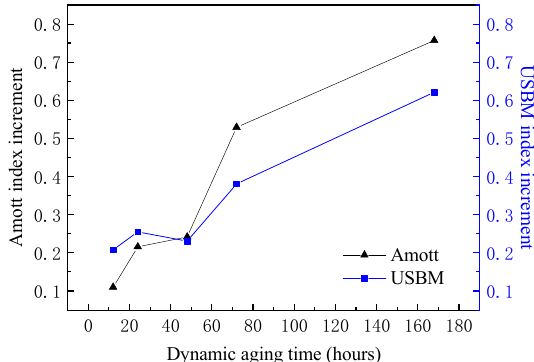
Figure 7. Wettability-index increments vs. dynamic-aging time.